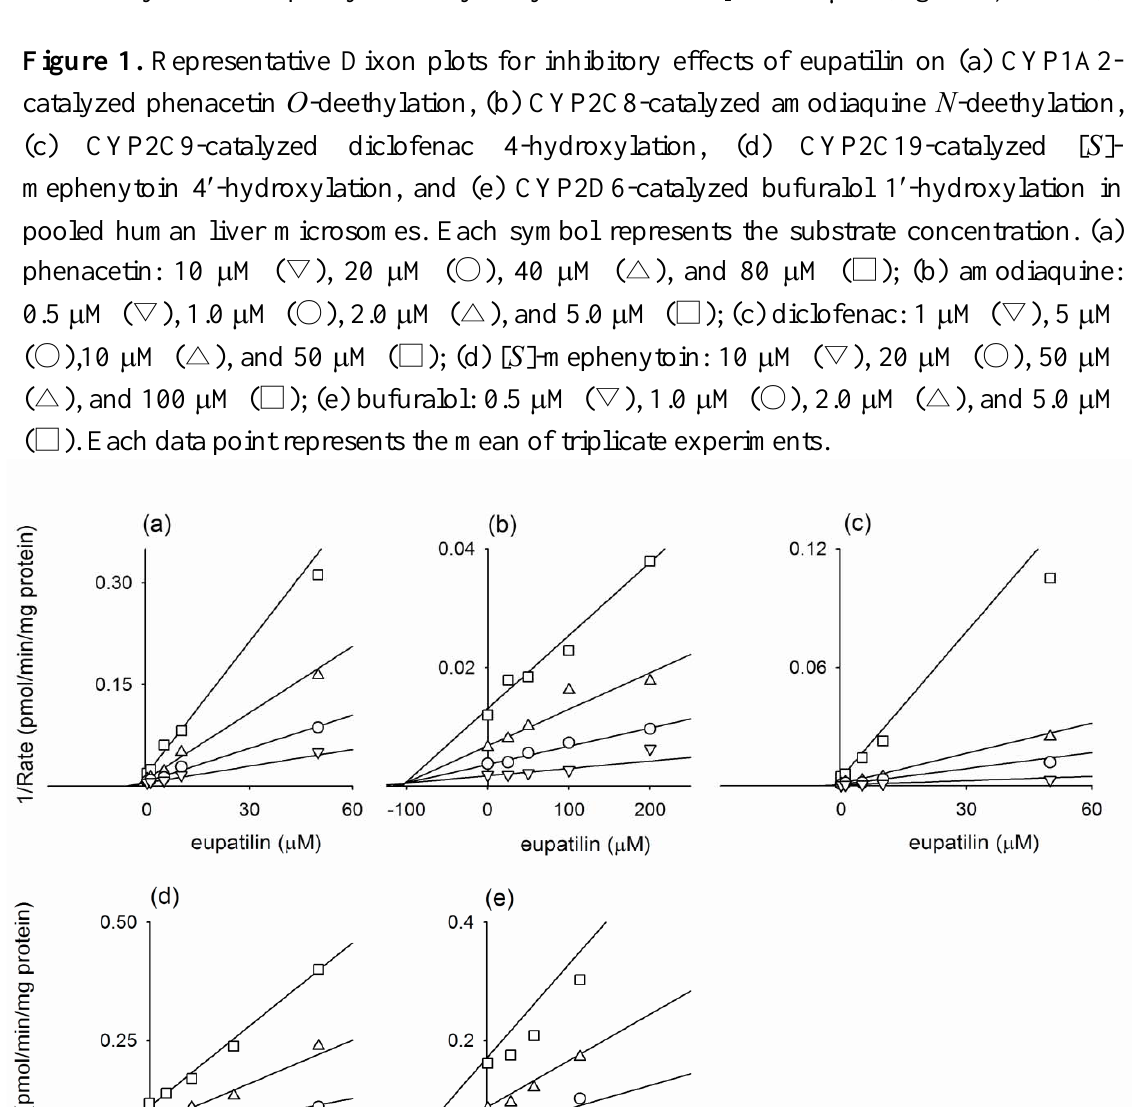
2. Eupatilin showed the mixed-type inhibition for CYP2C9-catalyzed diclofenac 4-hydroxylation ( K , 1.6 μ M; α , 10.3) and CYP2C19-catalyzed [ S ]-mephenytoin 4'-hydroxylation i